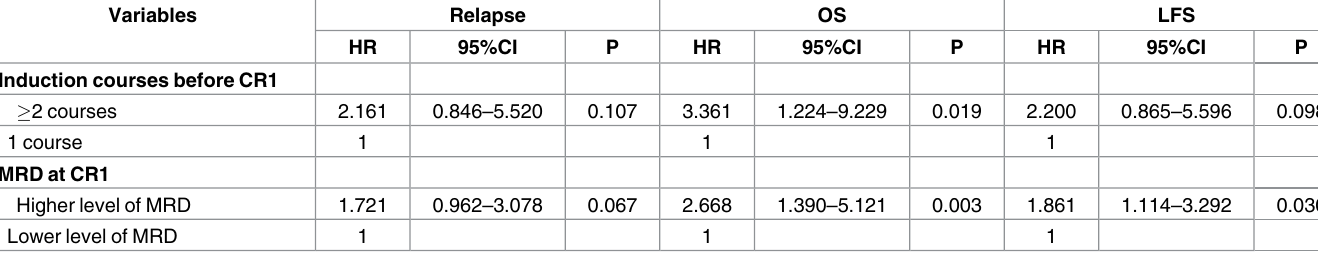
Table 2. Multivariate analysis for relapse, OS, and LFS in the chemotherapy arm.